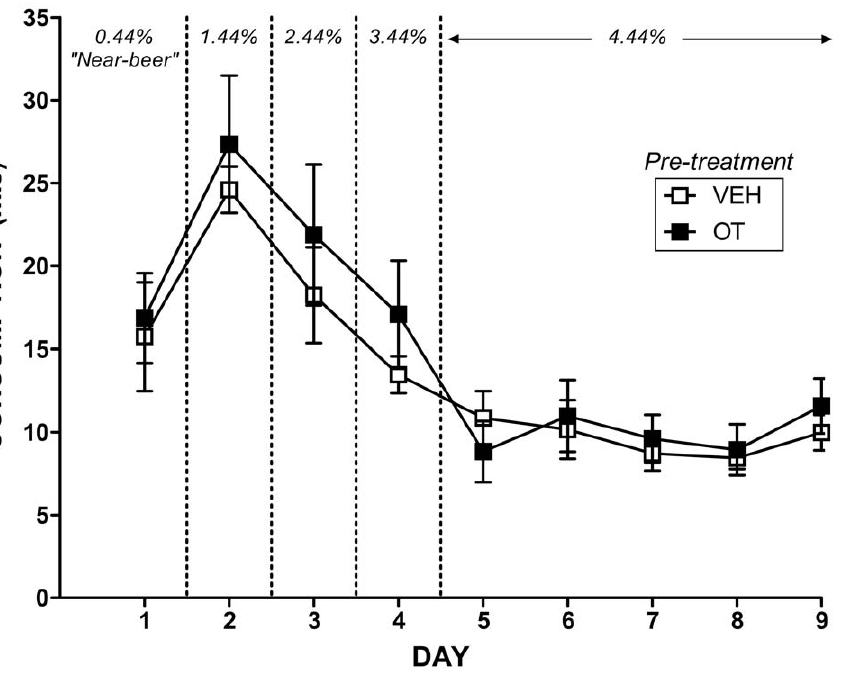
Figure 4. ‘‘Near-beer’’ and beer consumption during the 9 day alcohol induction phase in the lickometer apparatus. Mean ( 6 SEM) consumption (in mls) of increasing concentrations of beer (from .44% ‘‘near-beer’’ up to 4.44% EtOH beer). The 9 day induction period began 21 days after the cessation of 10 consecutive days of once per day treatments with either 1 mg/kg OT or equivalent VEH saline. Subjects were placed in the lickometer for one 70 min session per day. N=8 per condition. (Figure 7B) in the OT compared to VEH animals, t (8) =2.22, p = 0.057.